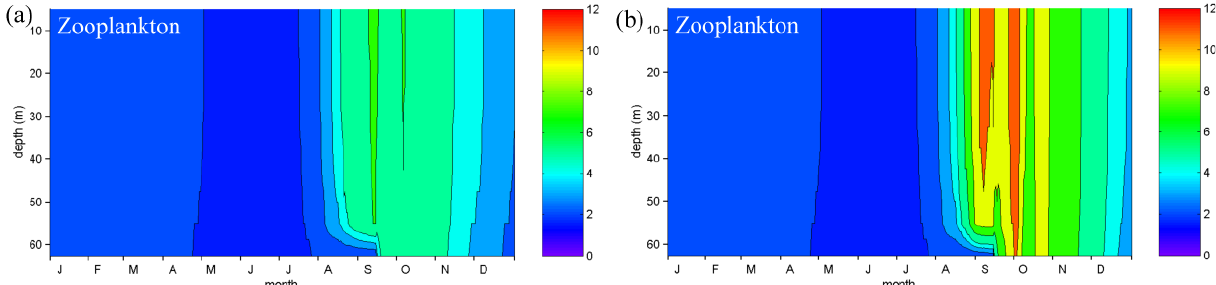
Fig. 11. Temporal evolution of the modelled vertical profile of zooplankton biomass [µmolCL − 1 ] in the upper 63m of the surface ocean at Papa during 2008 (a) without and (b) with iron fertilisation in August 2008.